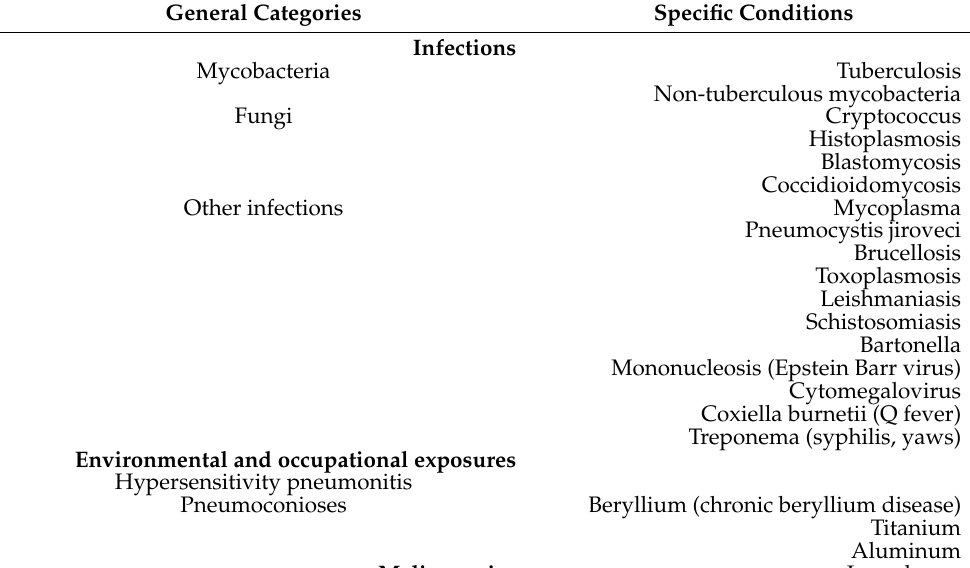
Table 2. A summary of granulomatous conditions other than